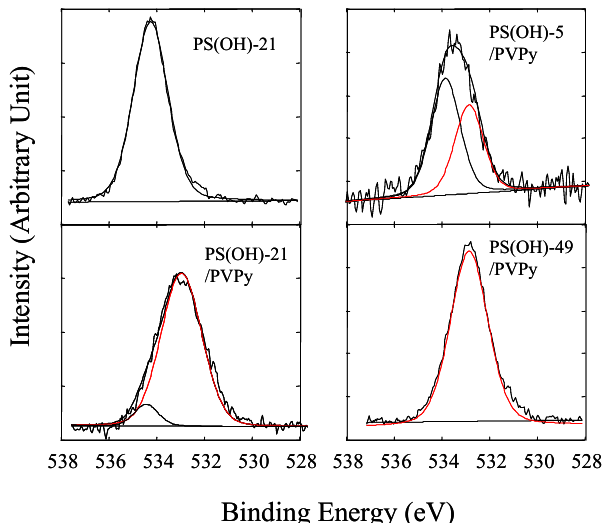
Figure 11. XPS O1s core-level spectra of pure PS(OH)-21, the PS(OH)-5/PVPy blend, and the PS(OH)-21/PVPy and PS(OH)-49/PVPy complexes [21].